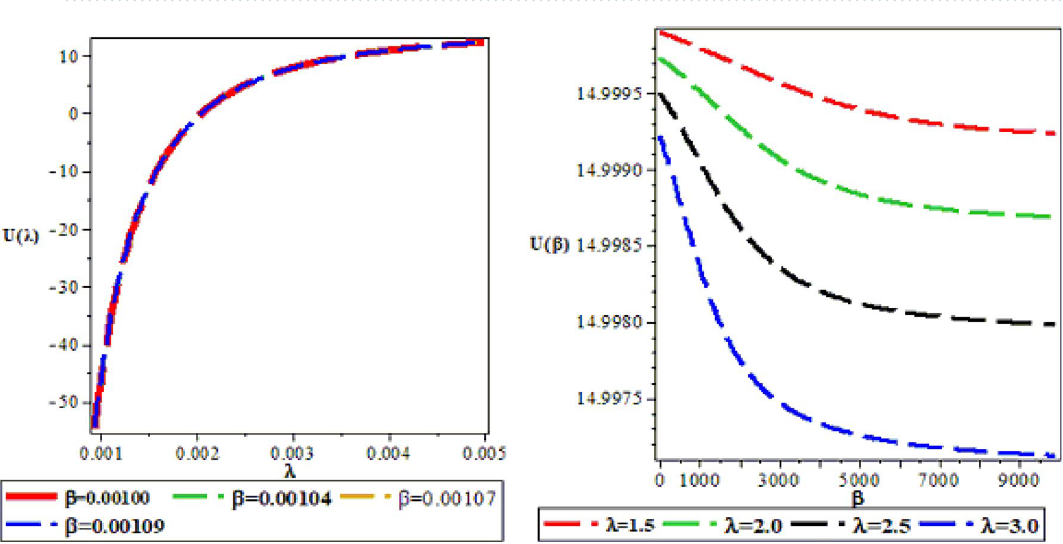
Figure 3. Variation of vibrational mean energy (U) against the maximum quantum state (λ) and the temperature parameter (β)